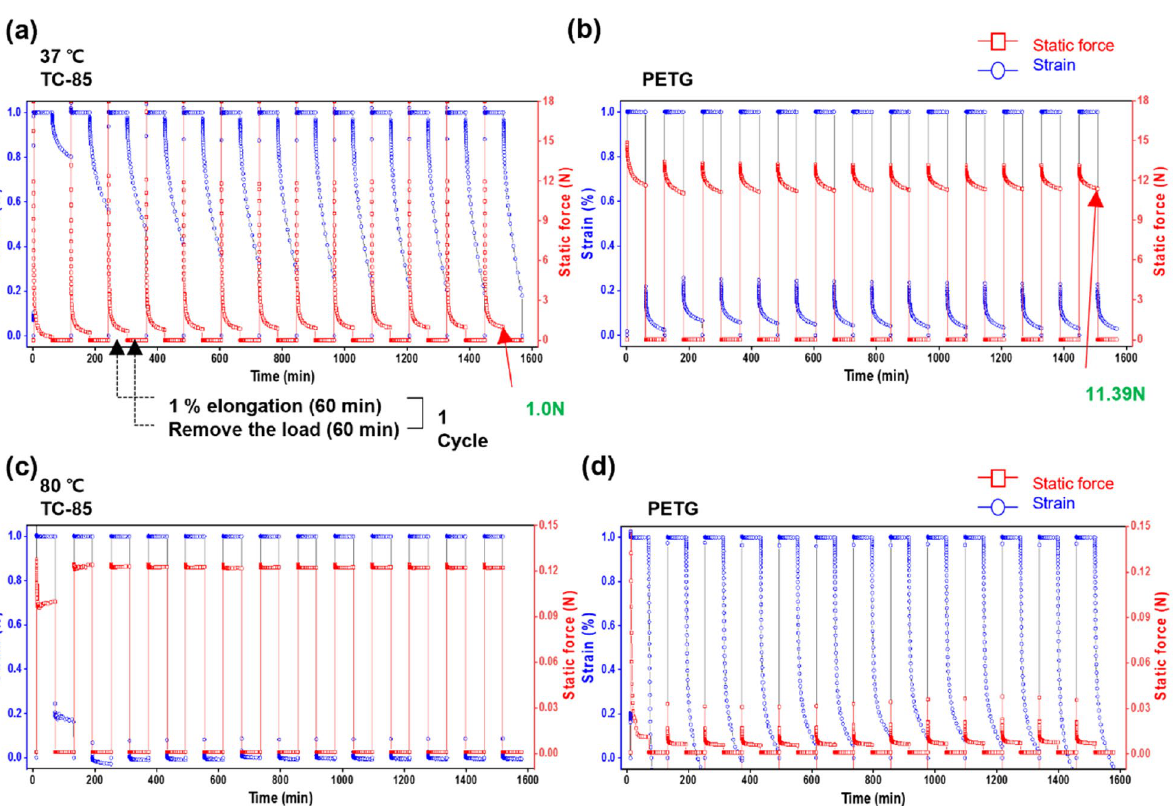
Figure 2. Stress relaxation and creep at 37 °C and 80 °C; The cycle of 1% elongation for 60 min and recovery for 60 min was repeated for13 cycles; ( a ) 37 °C, TC-85; ( b ) 37 °C, PETG; ( c ) 80 °C, TC-85; ( d ) 80 °C,